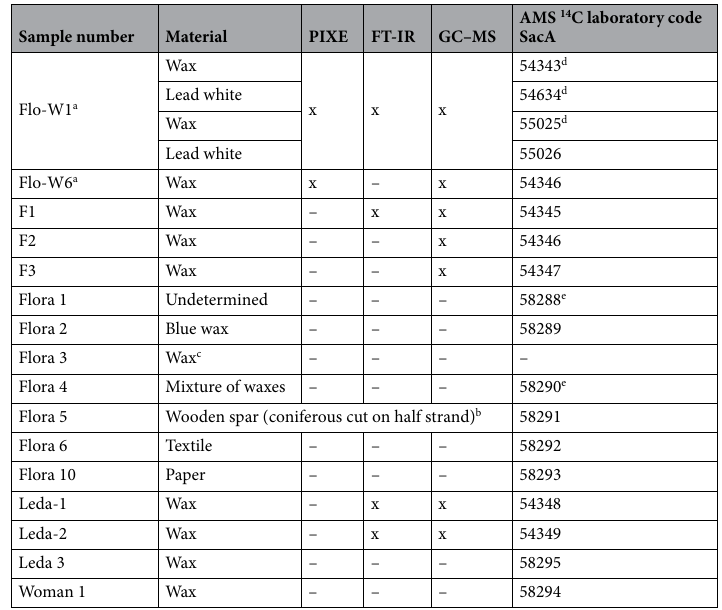
Table 1. Samples used for chemical analysis and AMS 14 C dating. a Loose sample. b Not enough material for dendrochronology (pers. comm. Catherine Lavier, dendrochronologist, C2RMF, Paris). c Wax from external parts, sample too small to be dated. d These samples were used for trials. e14 C dates were not calibrated since the composition was not known or